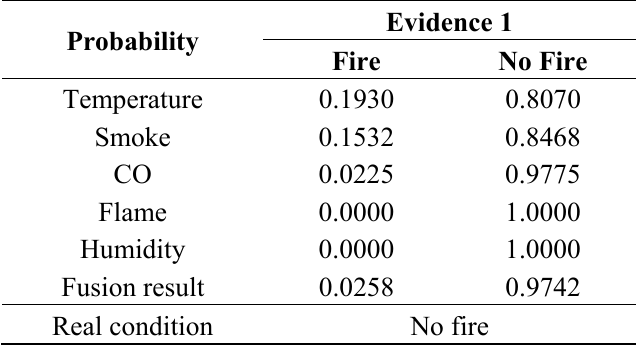
Table 2. Fire probability data and fusion result under Condition 1.